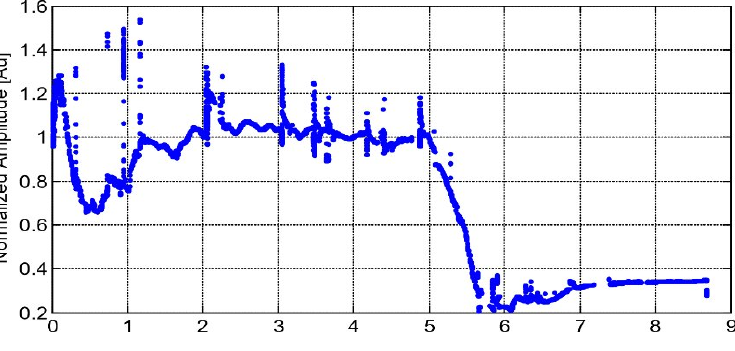
Figure 13. Bismuth titanate (BiTi) sensor pulse-echo amplitude of fundamental harmonic as a function of accumulated fluence. The spikes in amplitude occurred during periods where the reactor dropped to zero neutron power [14].